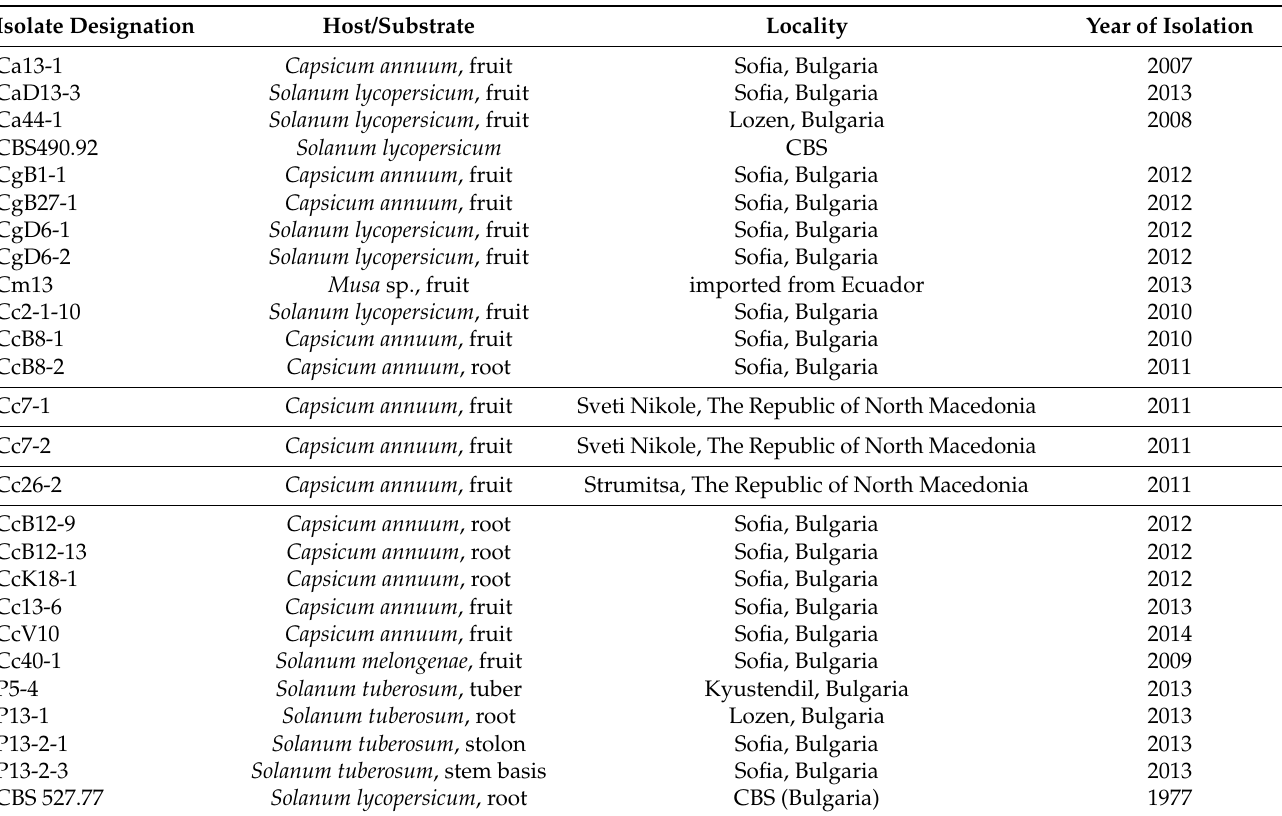
Table 1. Colletotrichum isolates examined in the